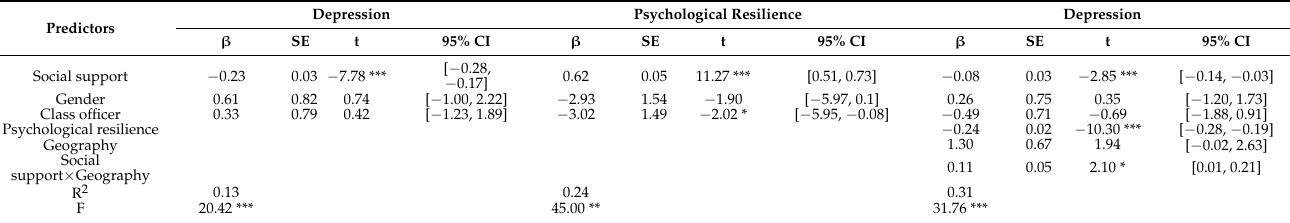
Table 4. A test of the moderated mediation effect (N = 424).